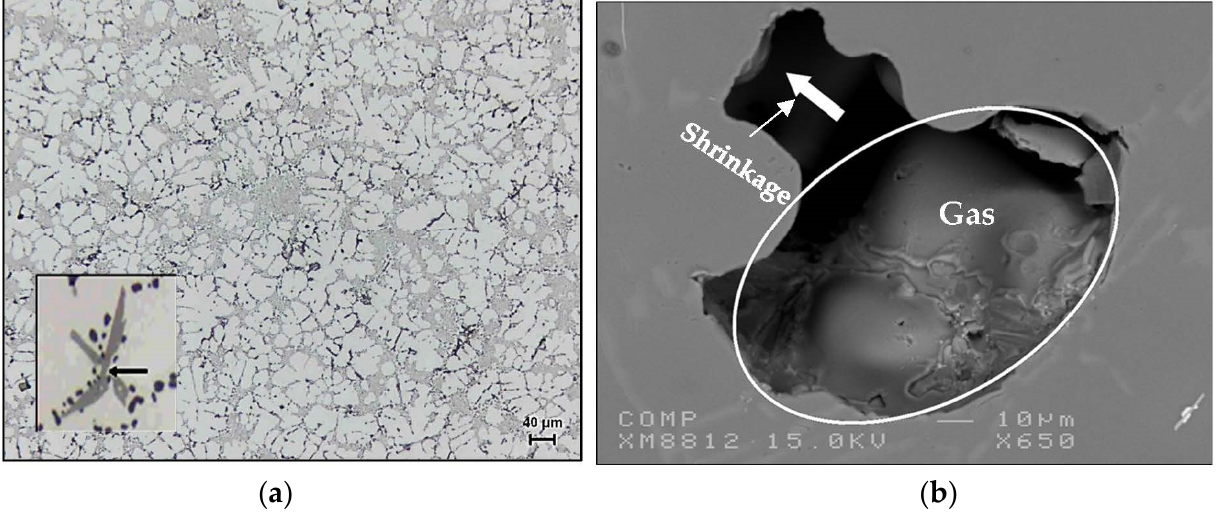
Figure 3. ( a ) Optical micrograph of 354 alloy containing 0.4% Zr - inset is an (Al,Si) 3 (Zr,Ti) phase particle (500×), arrowed; ( b ) backscattered electron micrograph of 413 alloy showing the branching of a gas pore into a shrinkage pore during the solidification process.